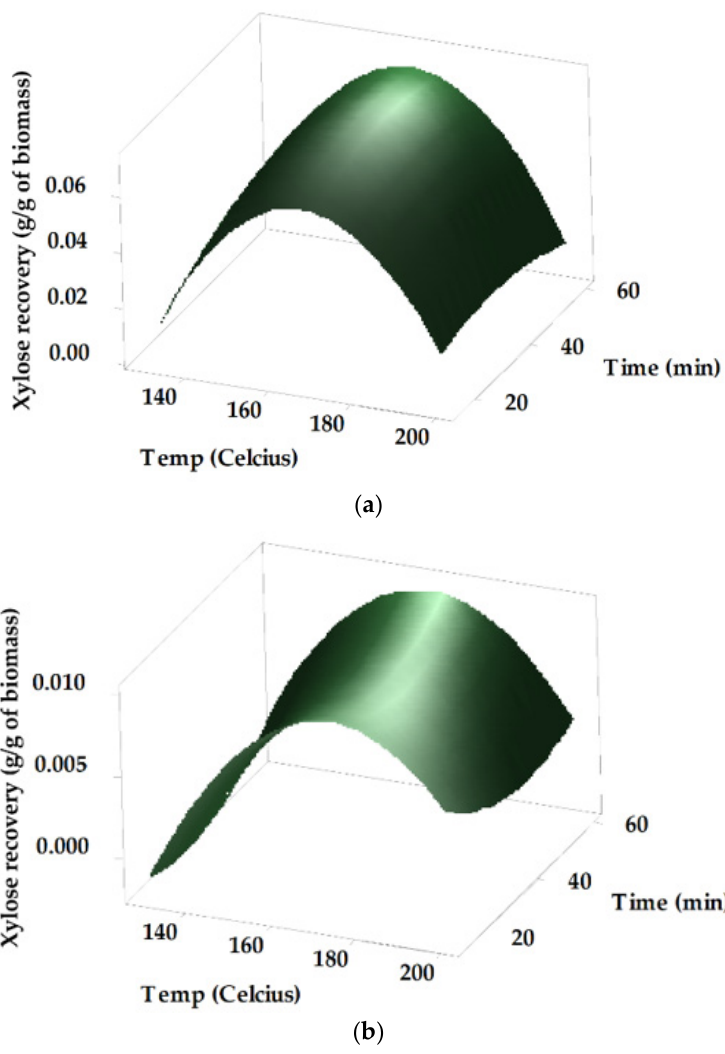
Figure 4. E ff ects of pretreatment time and temperature on xylose recovery ( a ) in solid pretreated OPEFB hydrolysate, and ( b ) in liquid pretreated OPEFB hydrolysate, at an SL of